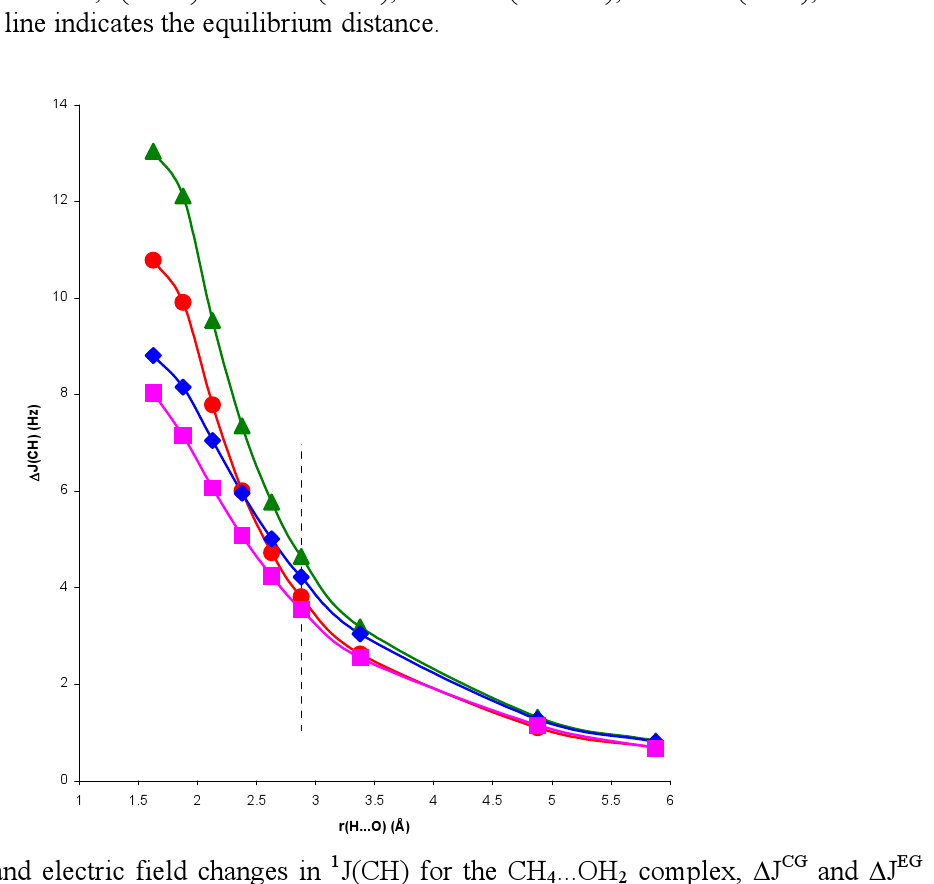
Figure 5. Complex and electric field changes in 1 J(CH) for the NCH...OH respectively, at every optimized geometry, with respect to 1 J(CH) for the isolated NCH molecule, as a function of the H...O distance, r(H...O). - (cid:88) - ∆ J EG (RPA), - (cid:81) - ∆ J EG (SOPPA), - (cid:86) - ∆ J CG (RPA), - (cid:79) - ∆ J CG (SOPPA). The dotted line indicates the equilibrium distance.